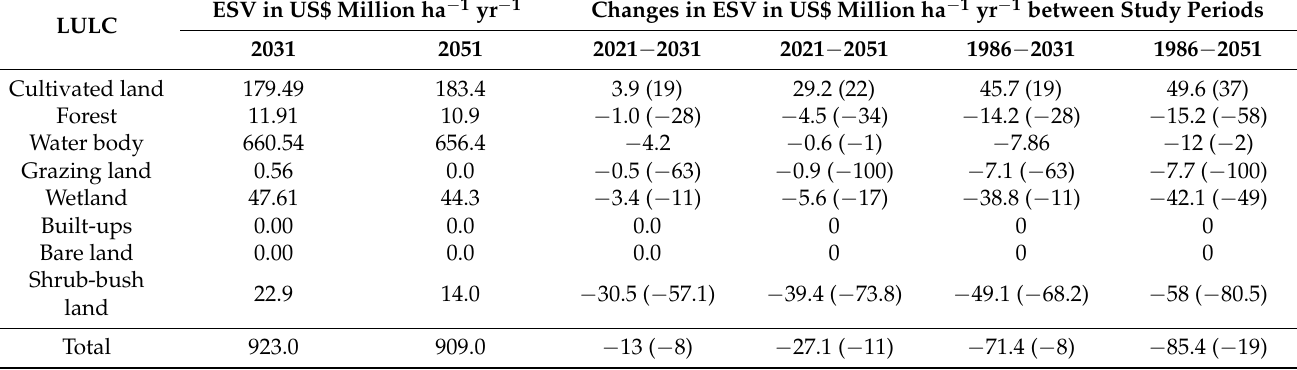
Table 6. ESV (US$ million ha − 1 yr − 1 ) of each LULC class and its change over study periods (1986 to 2051). Numbers in parentheses indicate a change of ESV in percent (%).